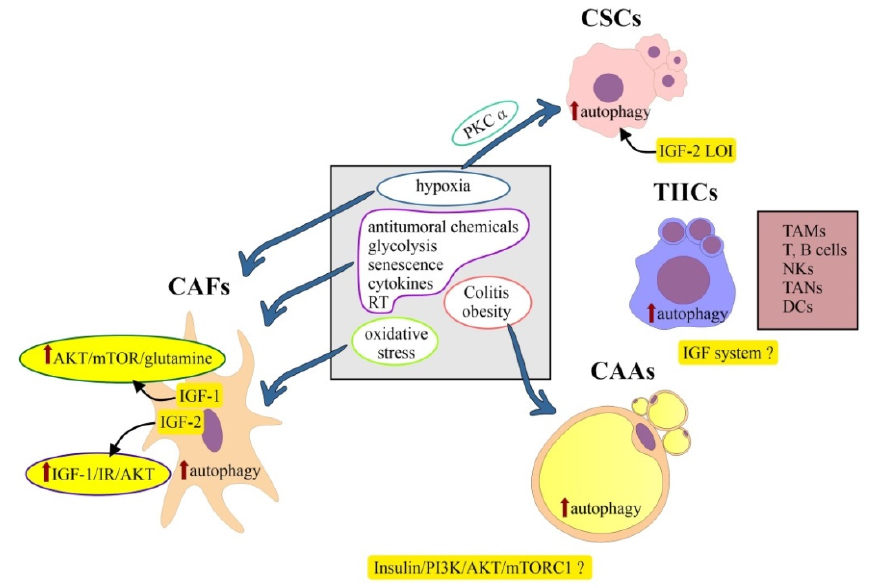
Figure 3. Simplified overview of the findings on the pro-autophagic factors (central box) and the potential role of insulin/IGF/PI3K/mTOR signaling (yellow boxes) in the regulation of autophagy in tumor microenvironment cells of colorectal cancer. Detailed mechanisms of regulation of autophagy involving the IGF pathway in TIICs and CAAs are the least understood. Role of IGF-1 in CAFs is mainly explained by the mechanisms of increased proliferation, migration and cell survival of cancer cells via irradiated CAFs, which activate AKT/mTOR/glutamine signaling in these cells. Legend: ↑ : increase/stimulation; ?: unknown role; → : lead to; AKT: serine/threonine kinase; AMPK: 5 (cid:48) adenosine-monophosphate-activated protein kinase; CAAs: cancer-associated adipocytes; CAFs: cancer-associated fibroblasts; CSCs: cancer stem cells; DCs: dendritic cells; IGF-1/2: insulin-like growth factor 1/2; IGF-2 LOI-IGF-2 loss of imprinting; IR: insulin receptor; NKs: natural killer cells; mTOR(C1): mammalian target of rapamycin (complex 1); PI3K: phosphatidylinositol-3-kinase; PKC α : protein kinase C alpha; RT: radiotherapy; TAMs: tumor-associated macrophages; TANs: tumor-associated neutrophils; TIICs: tumor-infiltrating immune